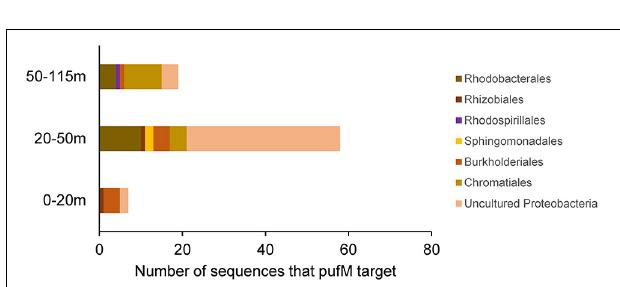
FIGURE 8 | Taxonomic composition of three group of samples that collected from three depth profiles (0–20, 20–50, 50–115 m) based on puf M marker genes targeted